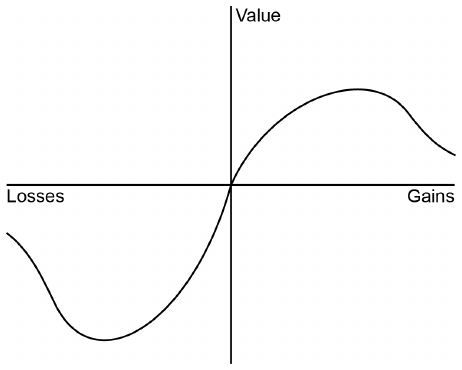
Figure 5. A modified value function.